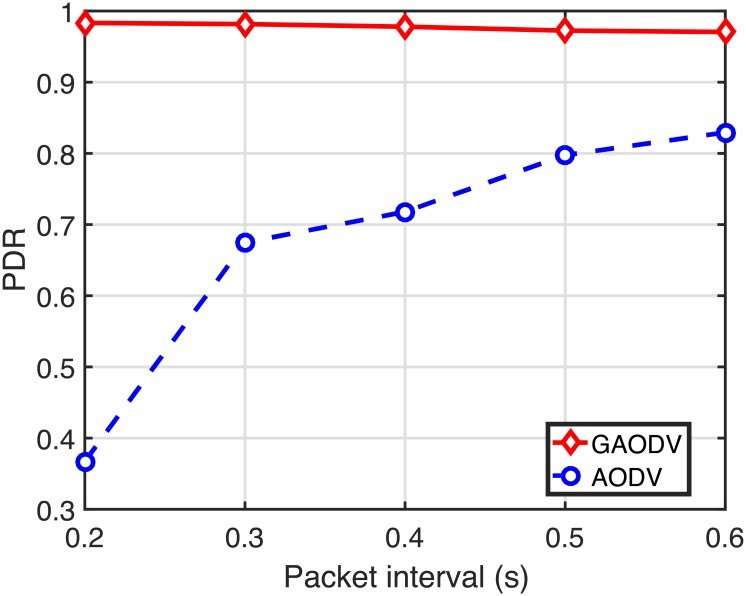
PDR for the change of the packet interval when NCBR = 10 and vmax = 5 m/s.